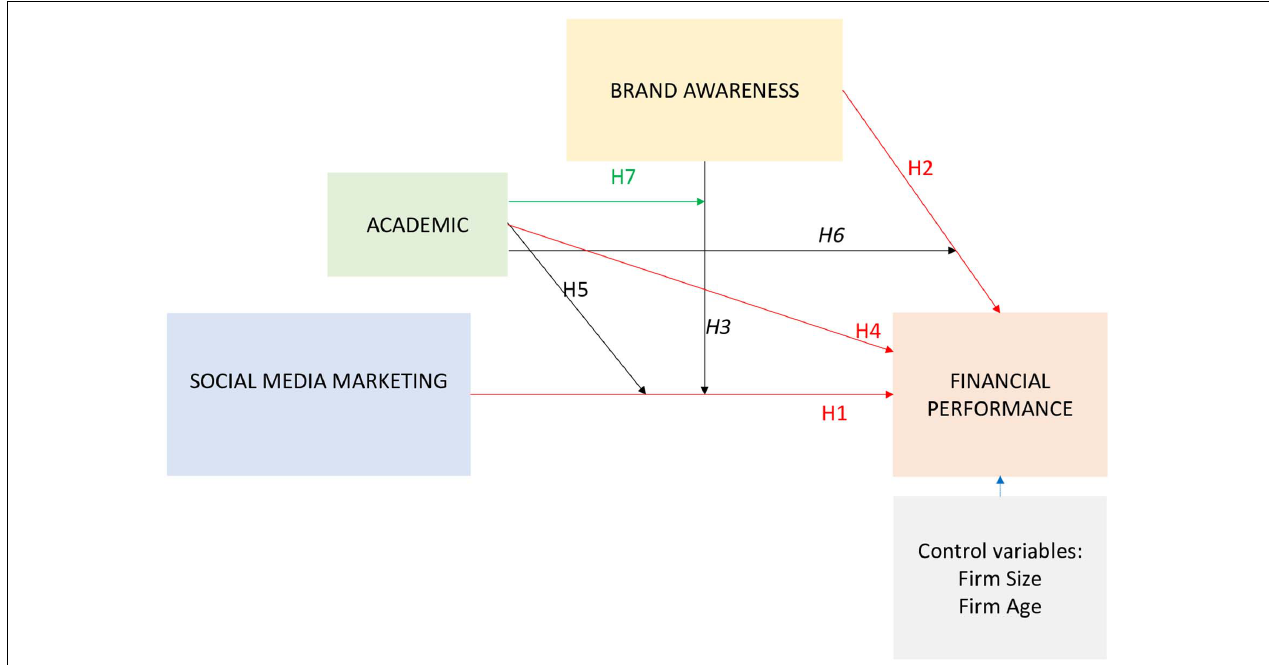
FIGURE 1 | Developed